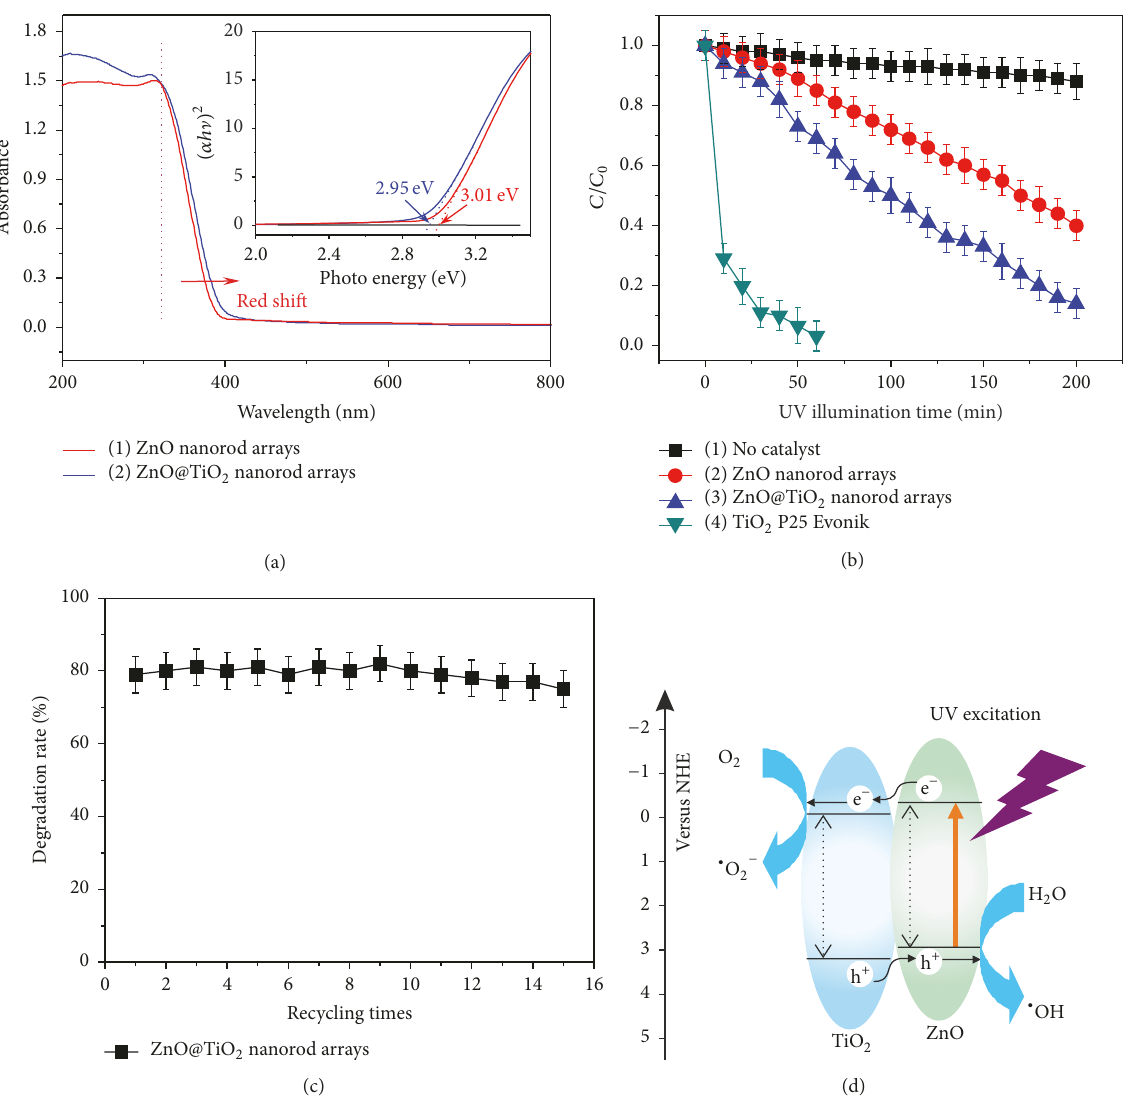
Figure 5: (a) Diffuse reflectance spectra (DRS) and (inset) plot of transferred Kubelka-Munch versus energy of the light absorbed for the ZnO nanorod arrays and ZnO@TiO 2 nanorod arrays. (b) Comparison of photocatalytic decomposition rates of MB with different catalysts. (c) Cyclic photodegradation of MB using ZnO@TiO 2 nanorod arrays. The same ZnO@TiO 2 nanorod arrays for degradation of MB are tested up to 15 cycles. The photocatalytic time is 180 min for each cycle. (d) Photogenerated electron transfer process in the ZnO@TiO 2 nanorod under UV illumination. The scale bars represent the standard deviations of three replicated